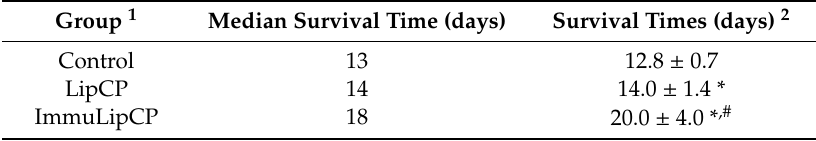
Table 2. Survival times for U87DR tumor-bearing mice after di ff erent